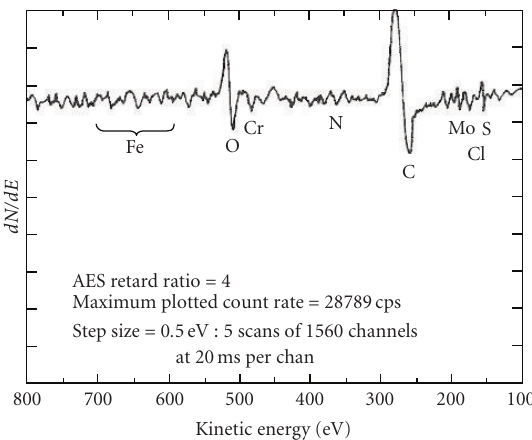
Figure 3: AES of Grease C at just before weld load; 280